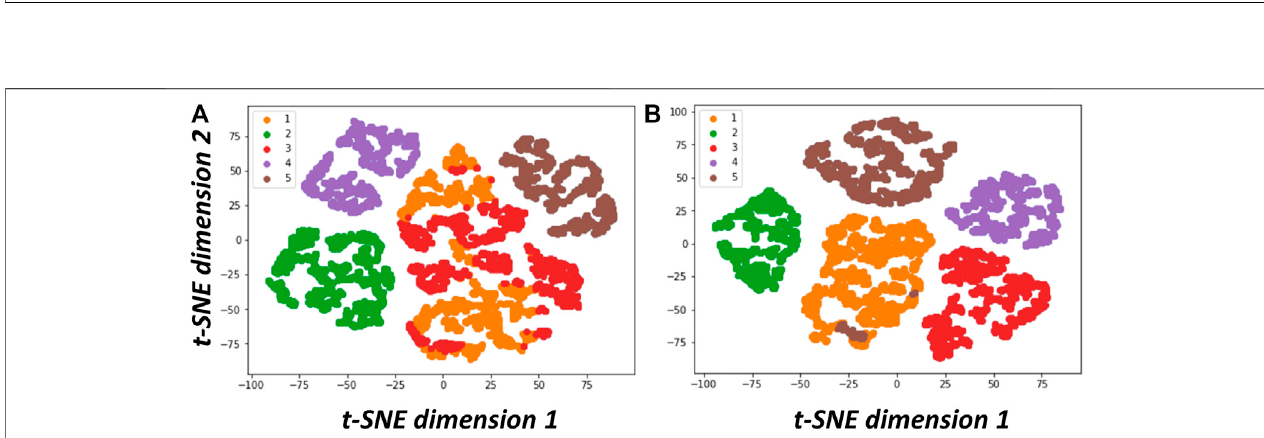
FIGURE6 | DatavisualizationofstructuralvariabilityresolvedviaPCAanalyses. (A) t-SNEplotoftheresultsfromclassicalPCA(Penczeketal.,2011). (B) t-SNEplotof the results from two-stage PCA (2SDR) (Chung et al., 2020). As stated in Chung et al., 2020, We followed the procedure in Penczek et al., 2011 to generate a dataset containing 9,453 simulated cryo-EM particle images projected from fi ve 70S ribosome conformations with minor differences resulting from combinations of the absence or presenceoftRNA(transferRNA)andEF-G(elongationfactorG).Wethenresampledtheseparticleimagestogenerate11,0003Dvolumes(densitymaps)on75 × 75 × 75voxels.Next,wesolvedtheeigenvolumesusingPCA(Penczeketal.,2011).or2SDR(Chungetal.,2020).andcomparedtheperformanceofthesetwomethodsusingthe factorialcoordinatesde fi nedinPenczeketal.,2011.Thet-SNEplotsandk-meanswith5classesontheirfactorialcoordinatesindicatethattheeigenvolumessolvedby2SDR have clearly resolved the structural variability (This set of fi gures is adopted from Chung et al., 2020 with permission given by International Press.).